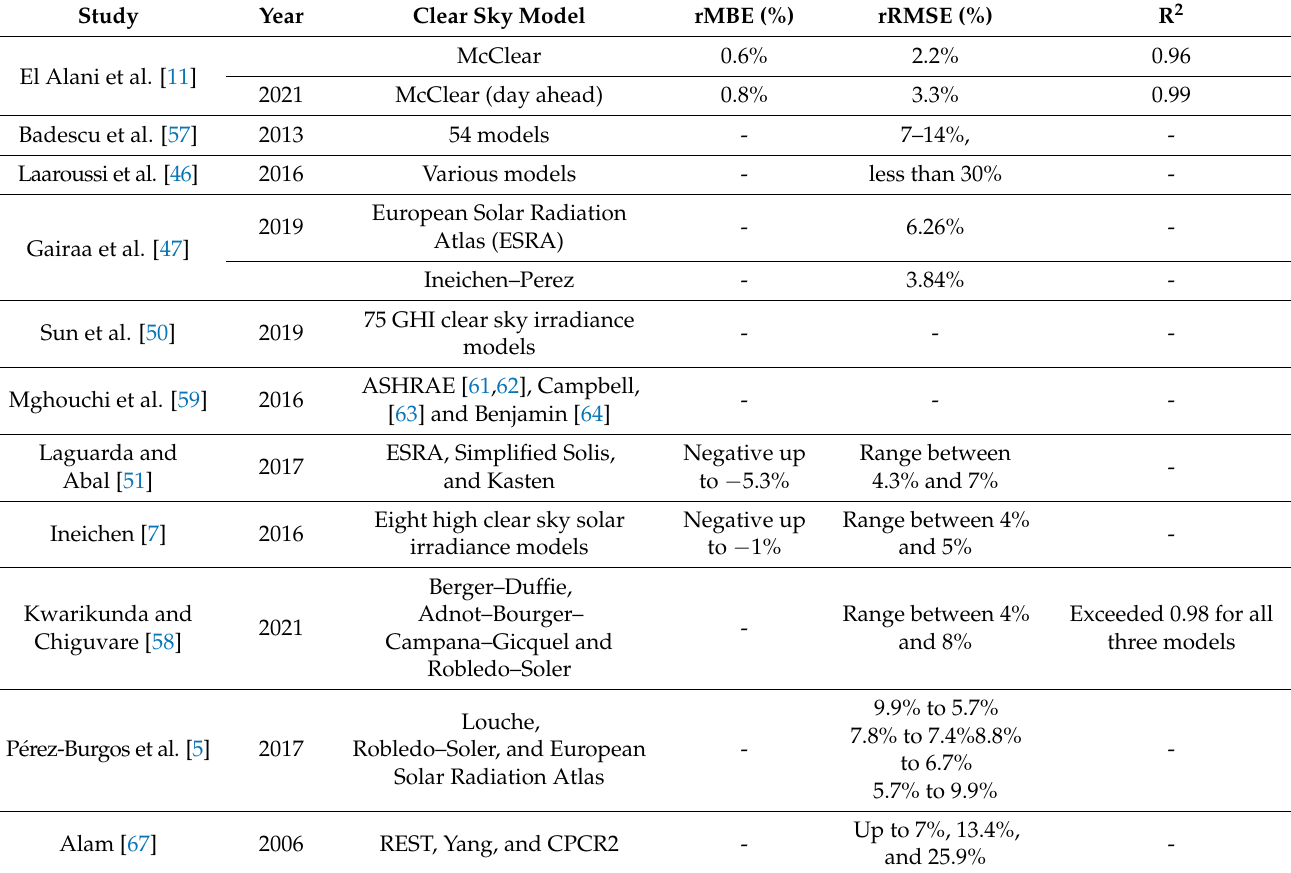
Table 1. Overview of the verification results from the reviewed